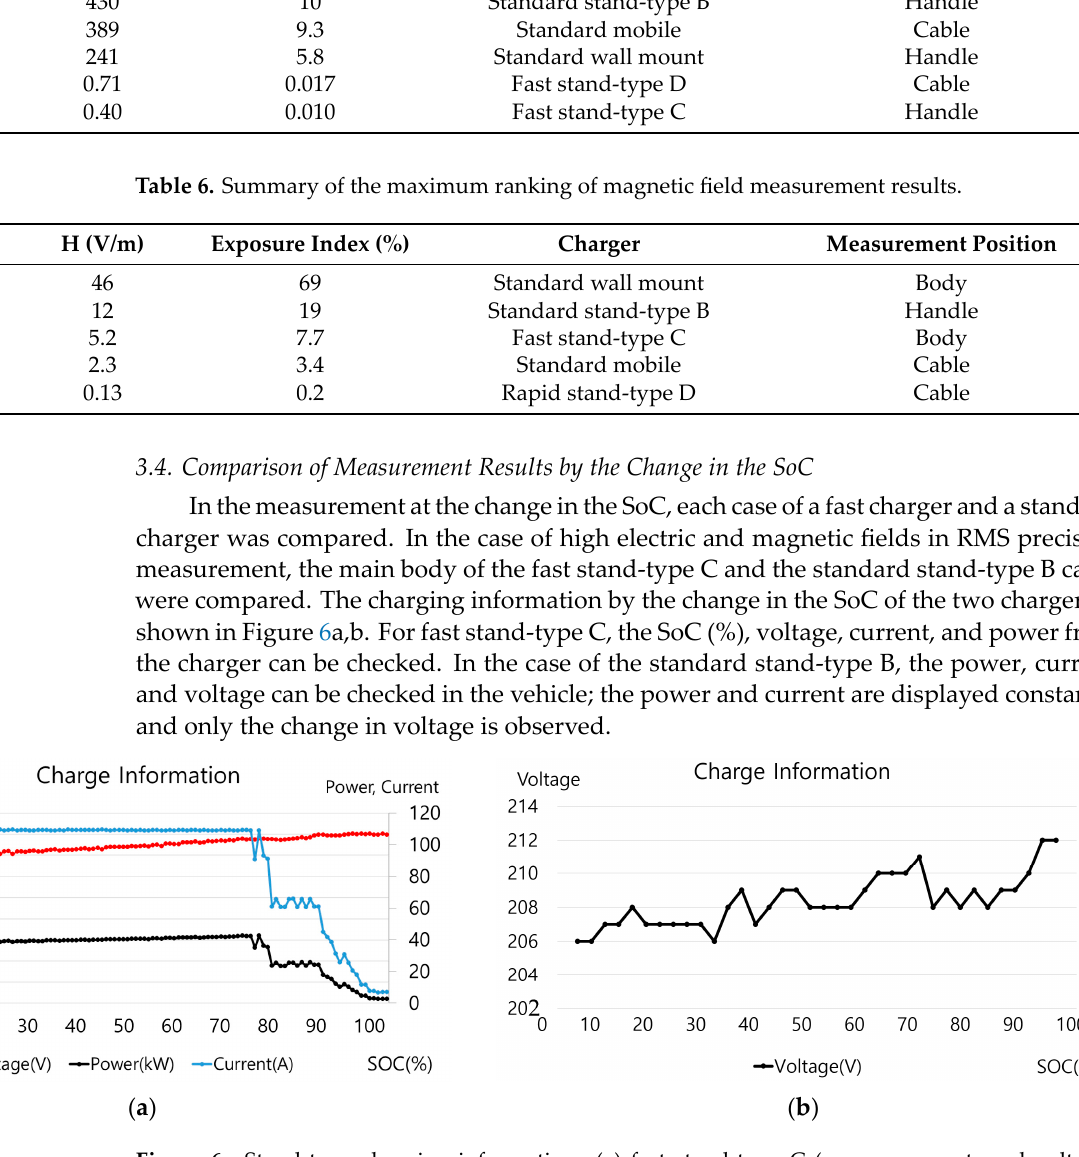
Table 5. Summary of the maximum ranking of the electric field measurement results.